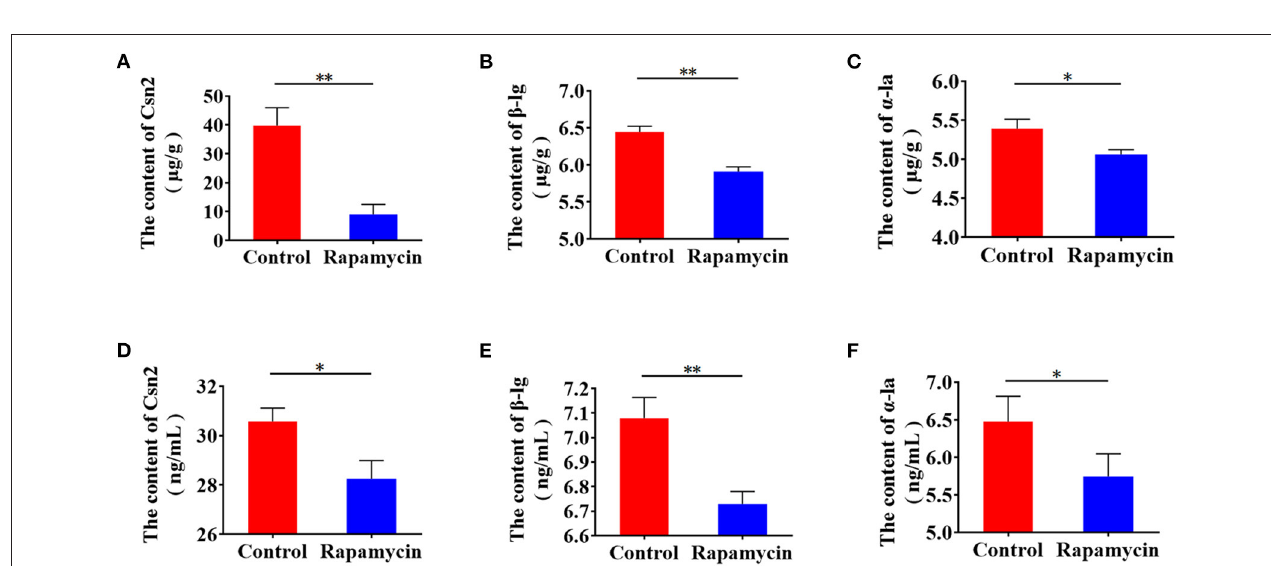
FIGURE 8 | Rapamycin suppresses milk protein synthesis. (A–C) Intracellular Csn2 ( β -casein), β -lg, and α -la after rapamycin treatment for 8h by ELISA. (D–F) Csn2 ( β -casein), β -lg, and α -la in cell culture medium. * p < 0.05; ** p < 0.01. n = 3 independent experiments.